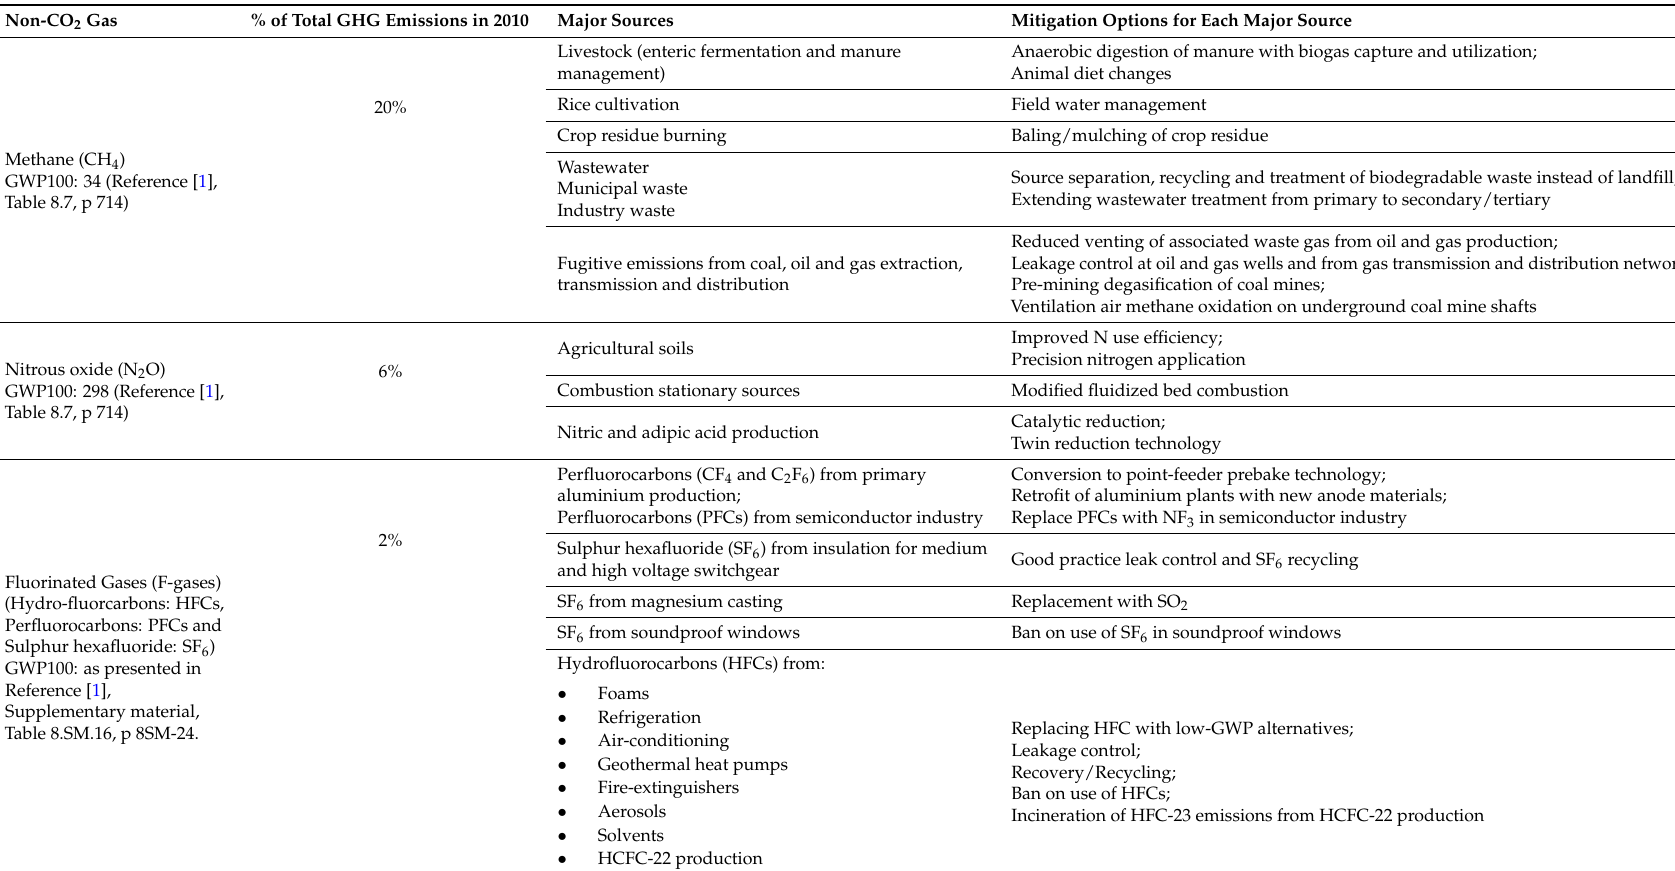
Table A1. Source and mitigation options for non-CO 2 greenhouse